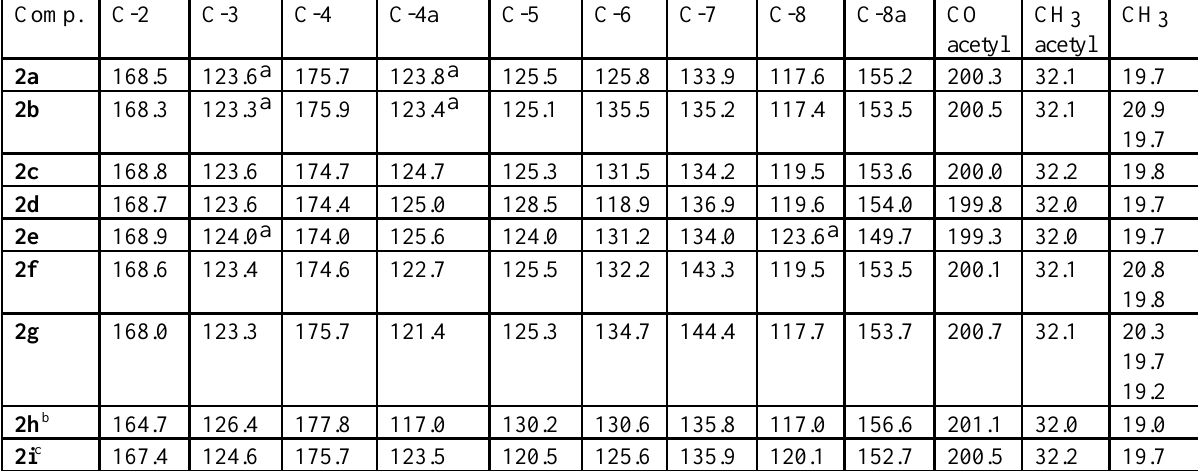
Table 3. 13C-NMR spectra of the compound 2a -